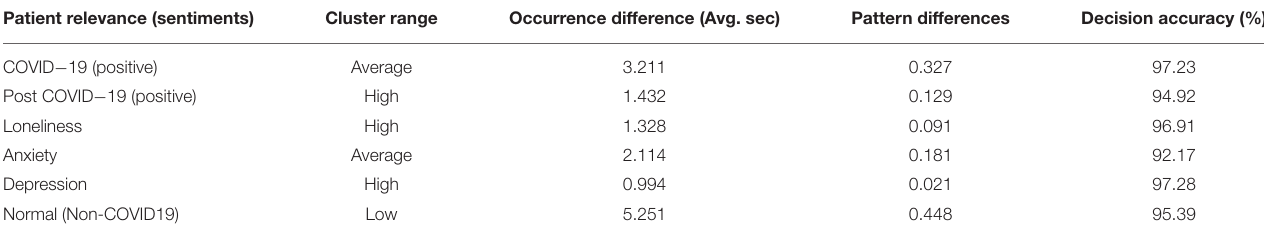
TABLE 1 | Decision support and evaluation parameters.